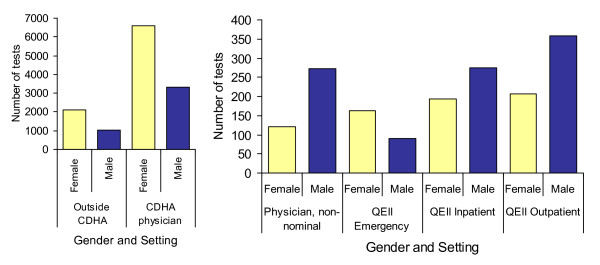
Number of HIV Screening Tests by Sex and Test Setting, CDHA Laboratory, April 16th 2009 - April 15th 2010.